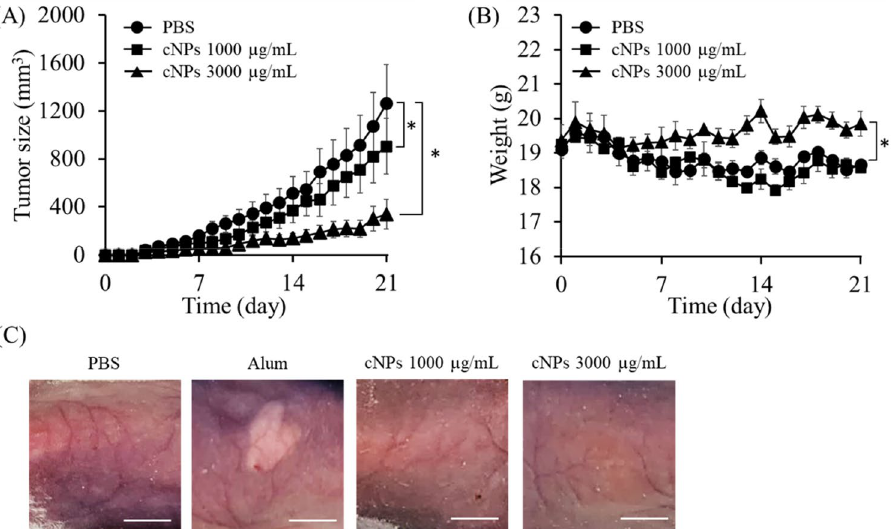
Figure 7. Tumor growth suppression in tumor-bearing mice after cNP administration. (A) Tumor size in tumor-bearing mice. Colon26 cells were subcutaneously injected into the back area of BALB/c mice. After the tumor size reached 50 mm 3 , cNPs at concentrations of 1000 or 3000 μg/mL (50 μL) were intratumorally administered every day. Results are expressed as the mean ± SD of three mice. *p < 0.05 vs. PBS group. (B) Body weight changes in different treatment groups. The change of body weight in tumor-bearing mice after cNP treatment. Results are expressed as the mean ± SD of three mice. *p < 0.05 vs. PBS group. (C) Skin inflammation in mice after cNP administration. 1000 or 3000 μg/mL cNPs, alum, and PBS (50 μL) were subcutaneously administered into the back area of BALB/c mice. After 24 h, the skin was observed. Scale bars indicate 5